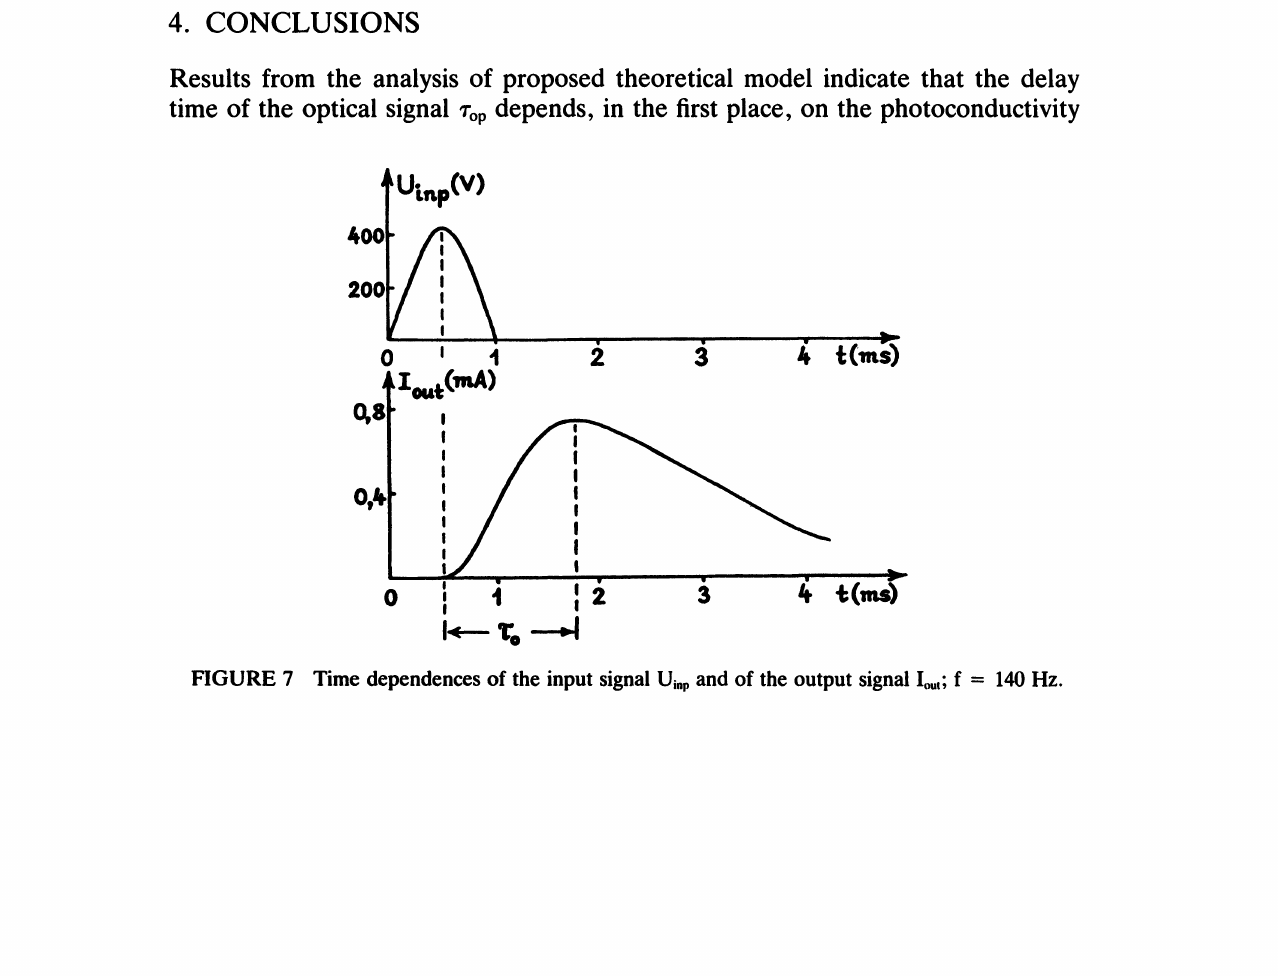
FIGURE 6 Thin film PC-EL type electric signal delaying circuit.